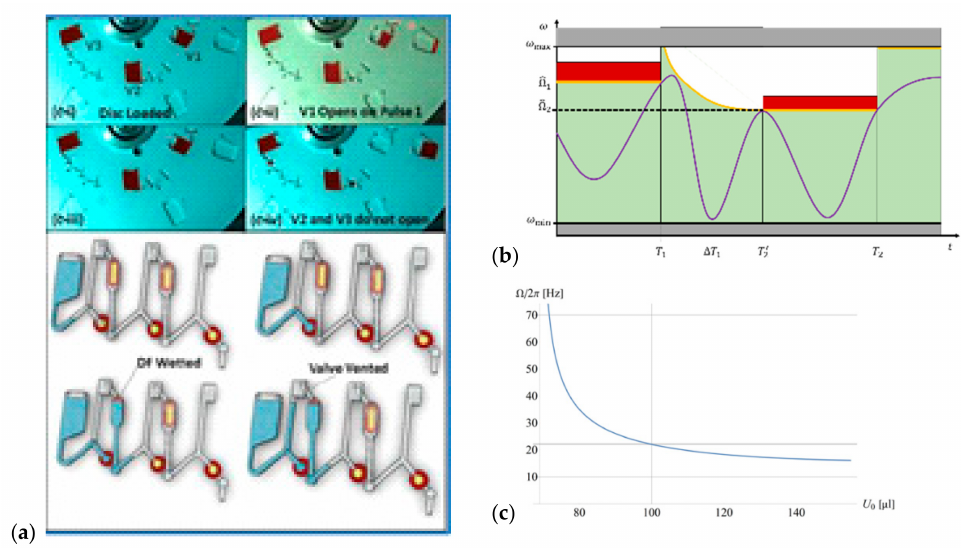
Figure 10. Pulse-actuated CP-DF valving (Adopted from [82]). ( a ) Photo and concept of the fluidic structure. ( b ) Spin protocol ω ( t ) and ( c ) decrease of the retention frequency Ω ( U 0 ) with the